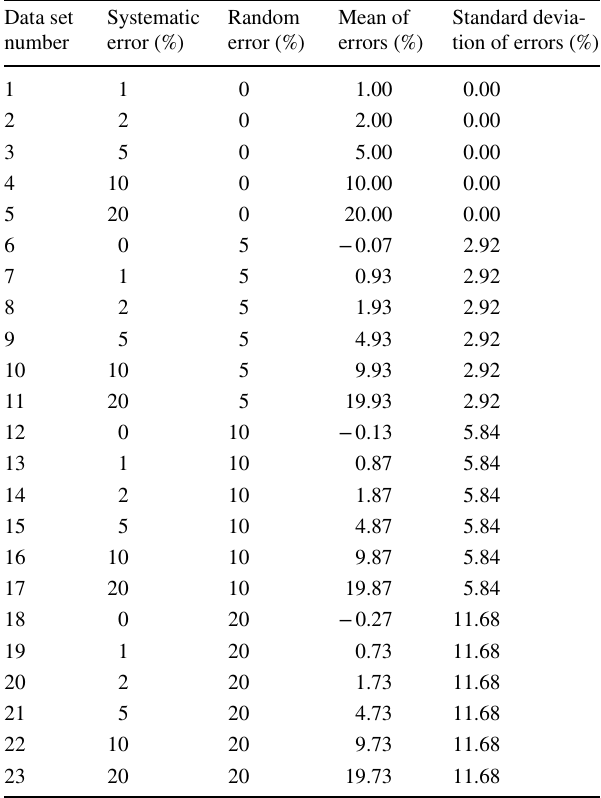
Table 2 The details of the errors in different data sets which were used in the history